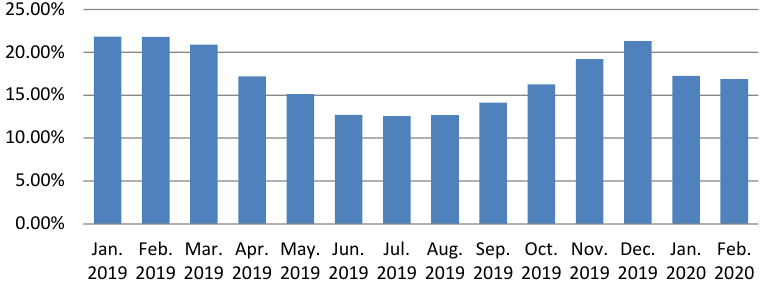
Figure 7. Own Technological Consumption (OTC) evolution in the case of the whole smart-meter based energy measurement analyzed sector.